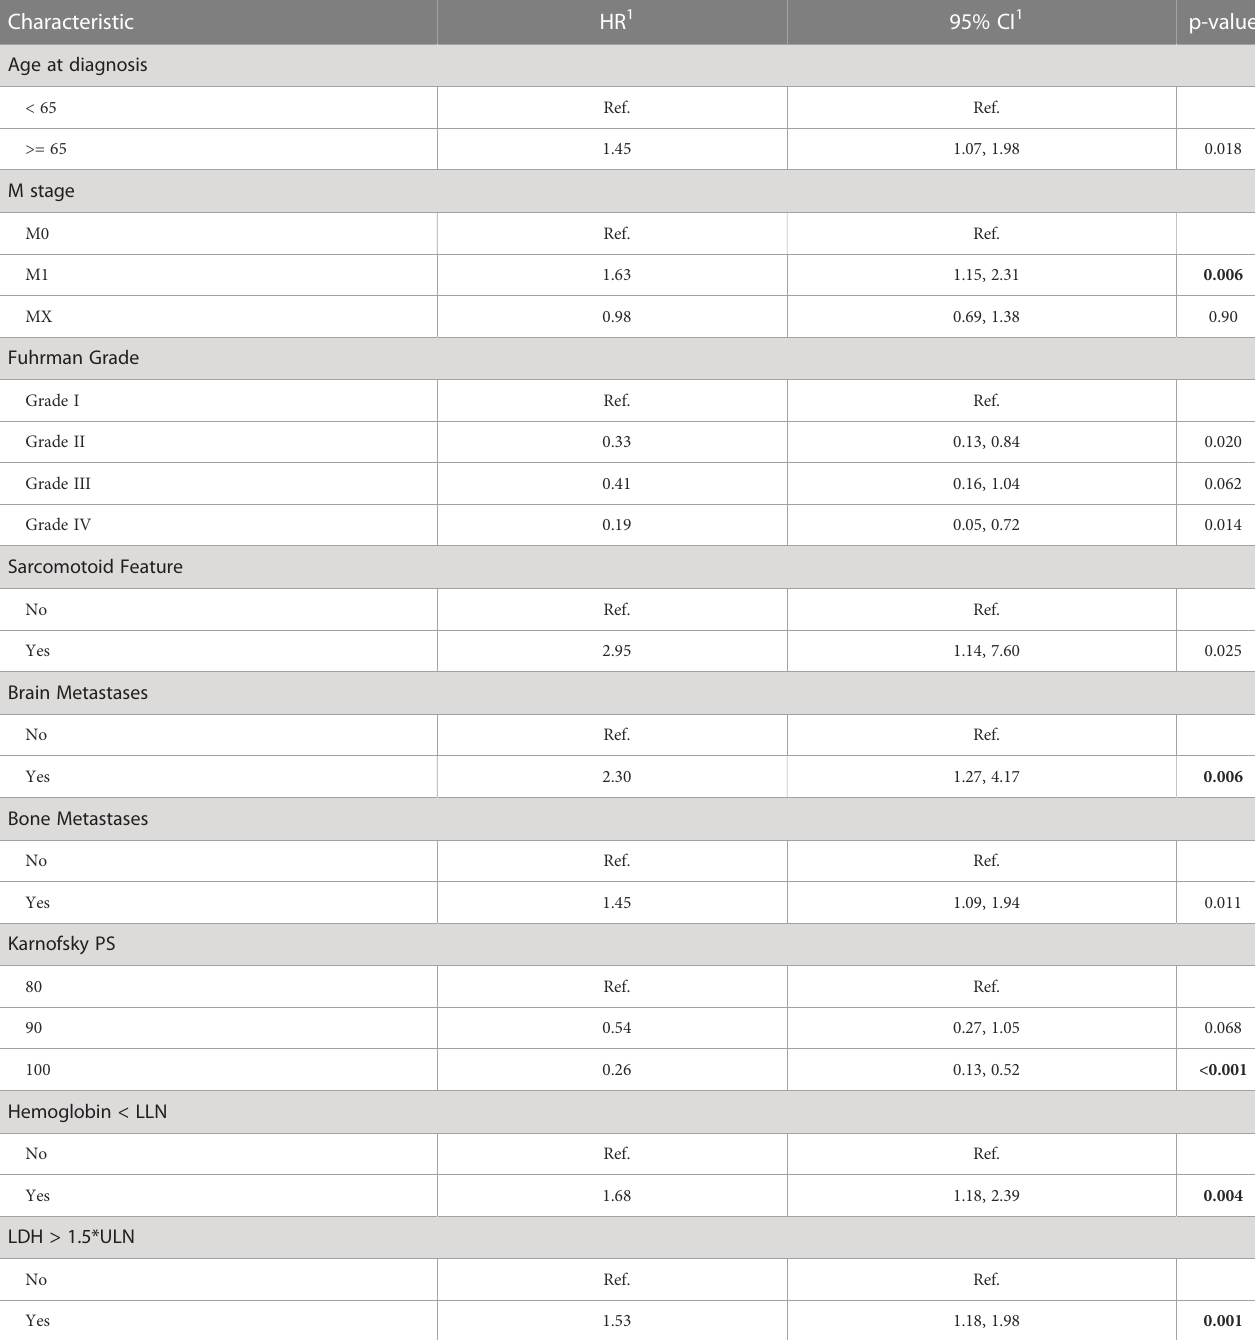
TABLE 3 Multivariate Cox regression of overall survival (OS) starting fi rst-line of systemic treatment for patients of this study. Characteristic HR 1 95% CI